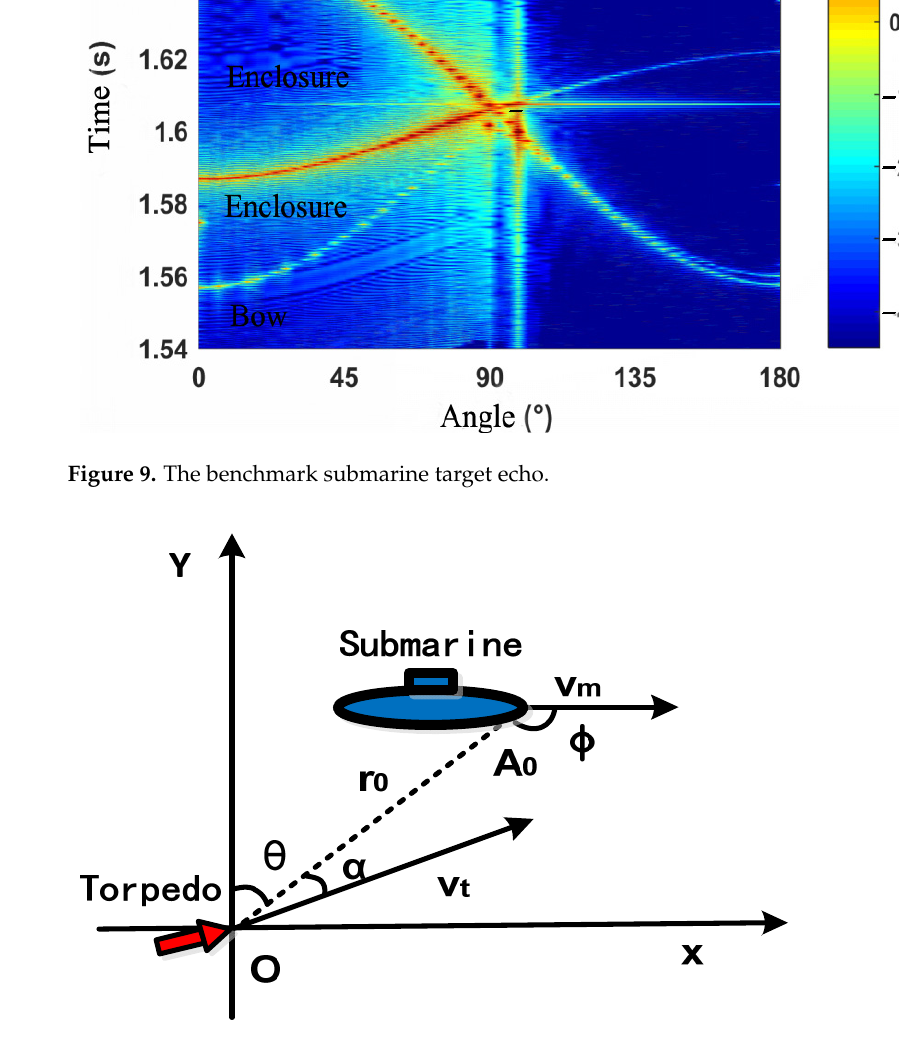
Figure 9. The benchmark submarine target echo.